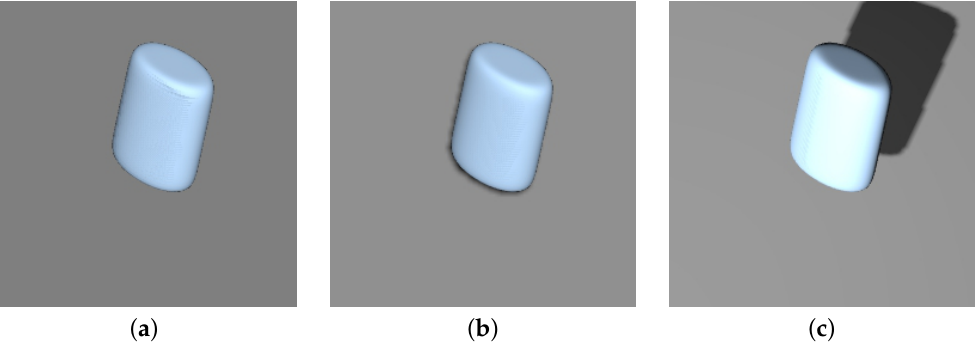
Figure 11. Examples of scene alterations used to counteract the Fixed z position requirement. Images depict identical superquadrics with minor scene alterations. The first image is the baseline. In the second, we enabled shadows in the scene. For the third image, we added a spotlight to cast larger shadows. All images contain blue superquadrics on grey backgrounds to allow for better visibility of shadows. ( a ) BoG ( Free z ); ( b ) add shadows; ( c ) add